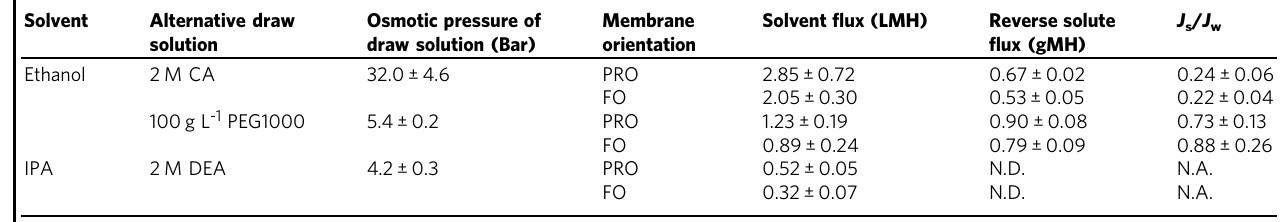
Table 4 Membrane performance with alternative draw solutions Solvent Alternative draw